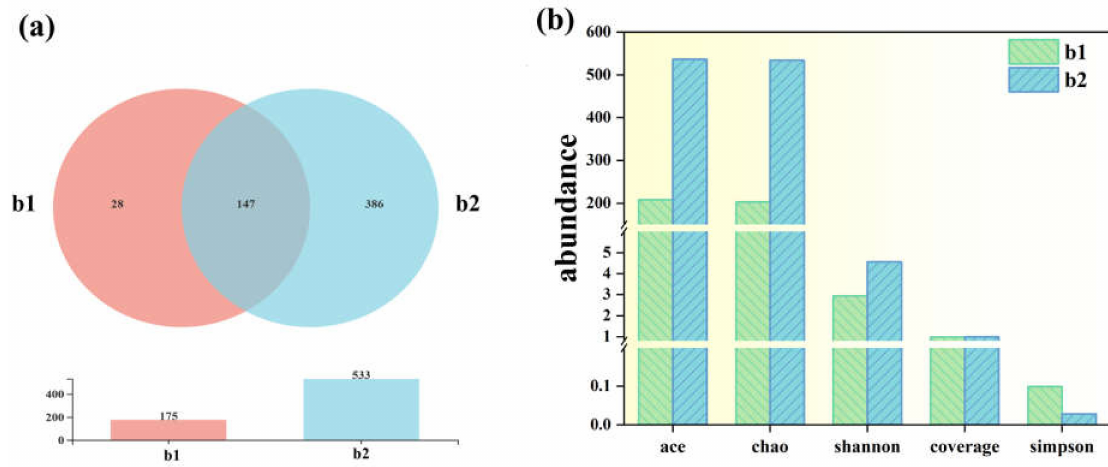
Figure 8. ( a )Venn diagram; ( b ) Diversity indexes of samples from SHD-EHD and